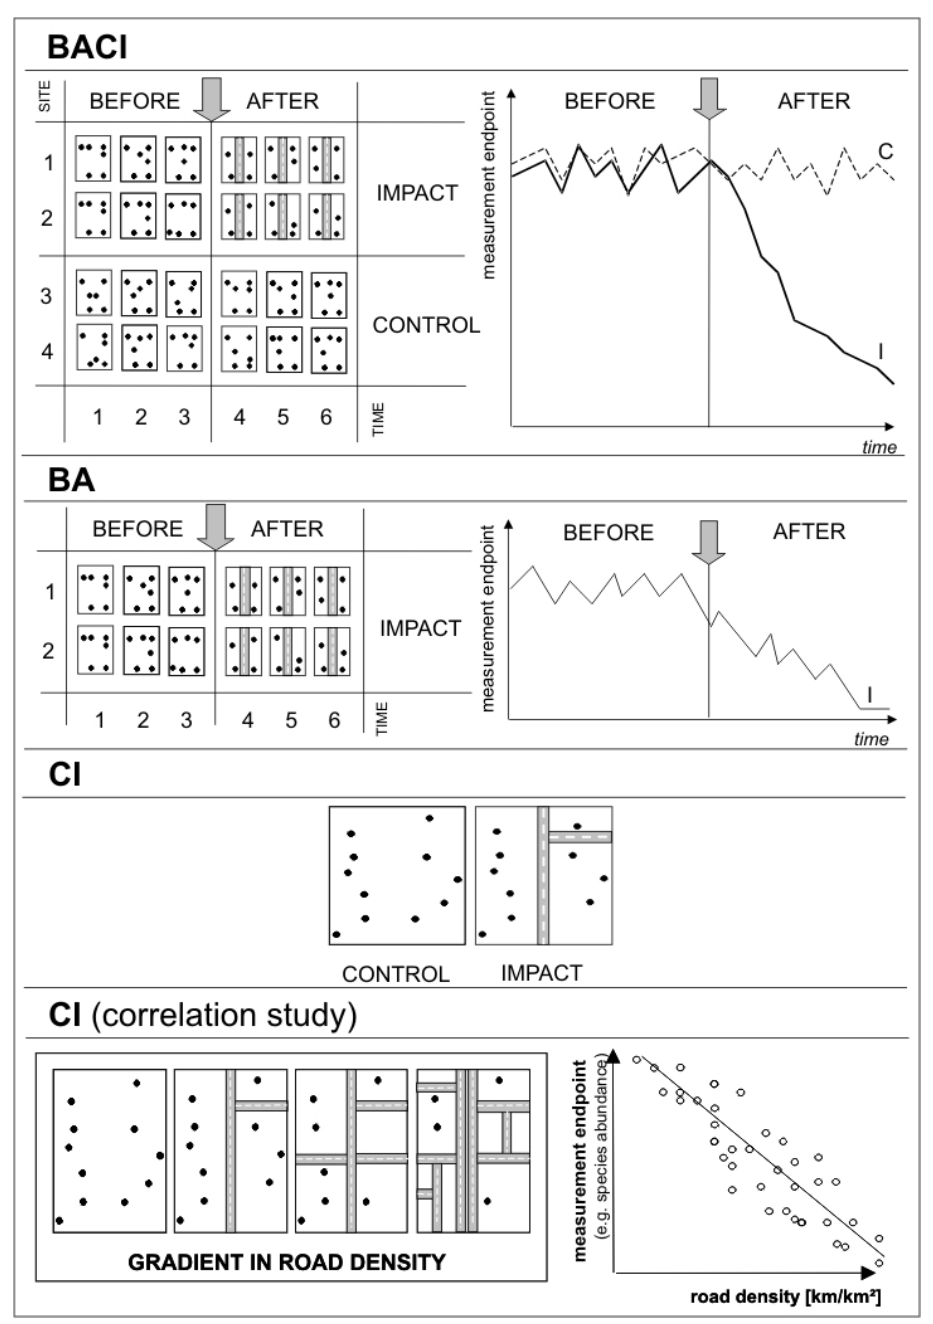
Fig. 3 . Study designs and hypothetical results for Question 1: Under what circumstances do roads affect population persistence? We use a road-construction before-after-control-impact (BACI) study design as an example (see Fig. 2). The study types include before-after-control-impact (BACI), before-after (BA), and control-impact (CI) designs. The correlation study is a subtype of the CI